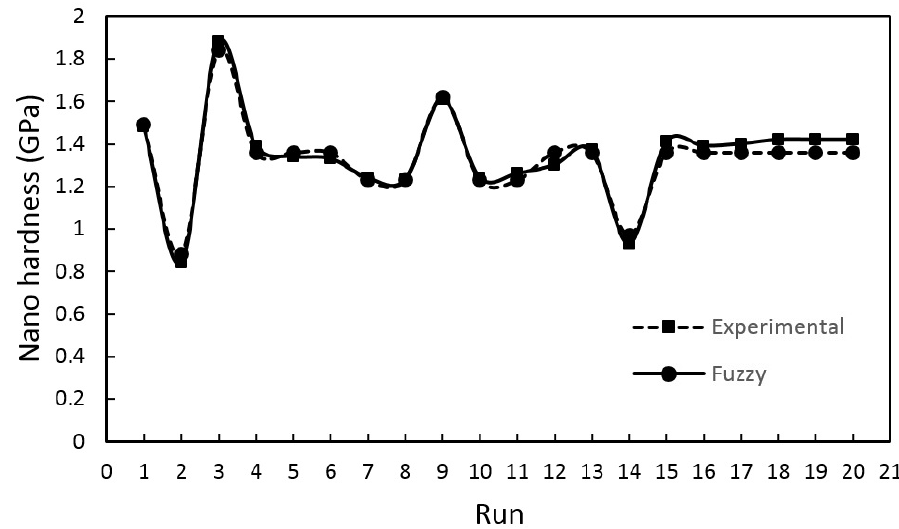
Figure 2. Micro-hardness and fuzzy micro-hardness results.